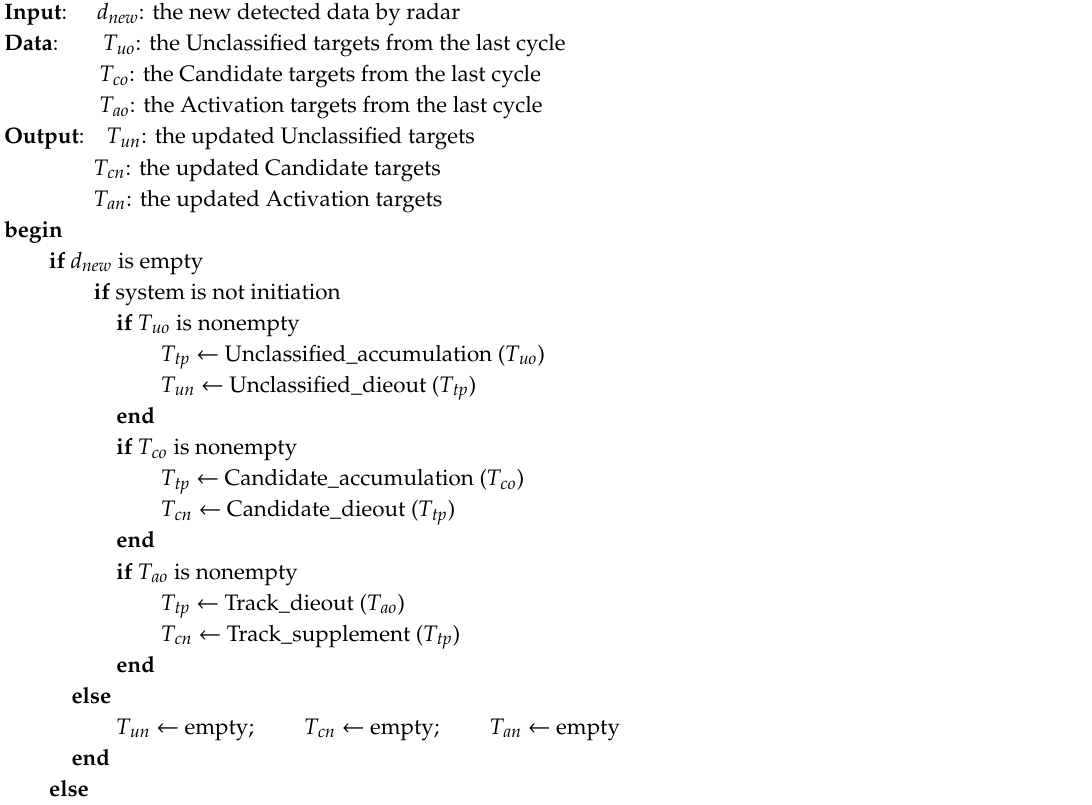
Algorithm 1. Pseudocode of track